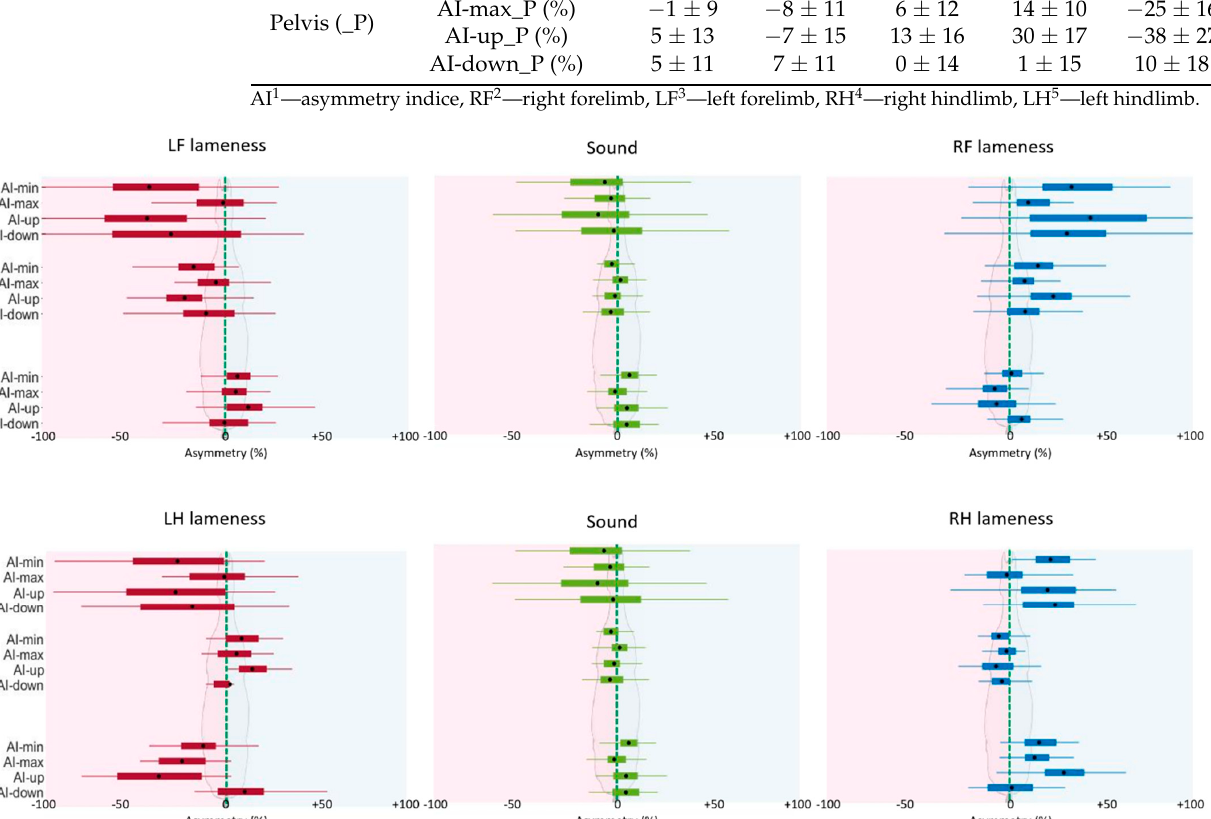
Figure 3. Boxplots of asymmetry indice (AI) in % for sound, left forelimb (LF), right forelimb (RF), left hindlimb (LH), and right hindlimb (RH) lame horses. The black dot represents the mean, the 2 extremities of the box are 25th and 75th percentiles, and extremities of the whiskers represent extreme data points not considered outliers. Negative value represents smaller movement on the left limb.